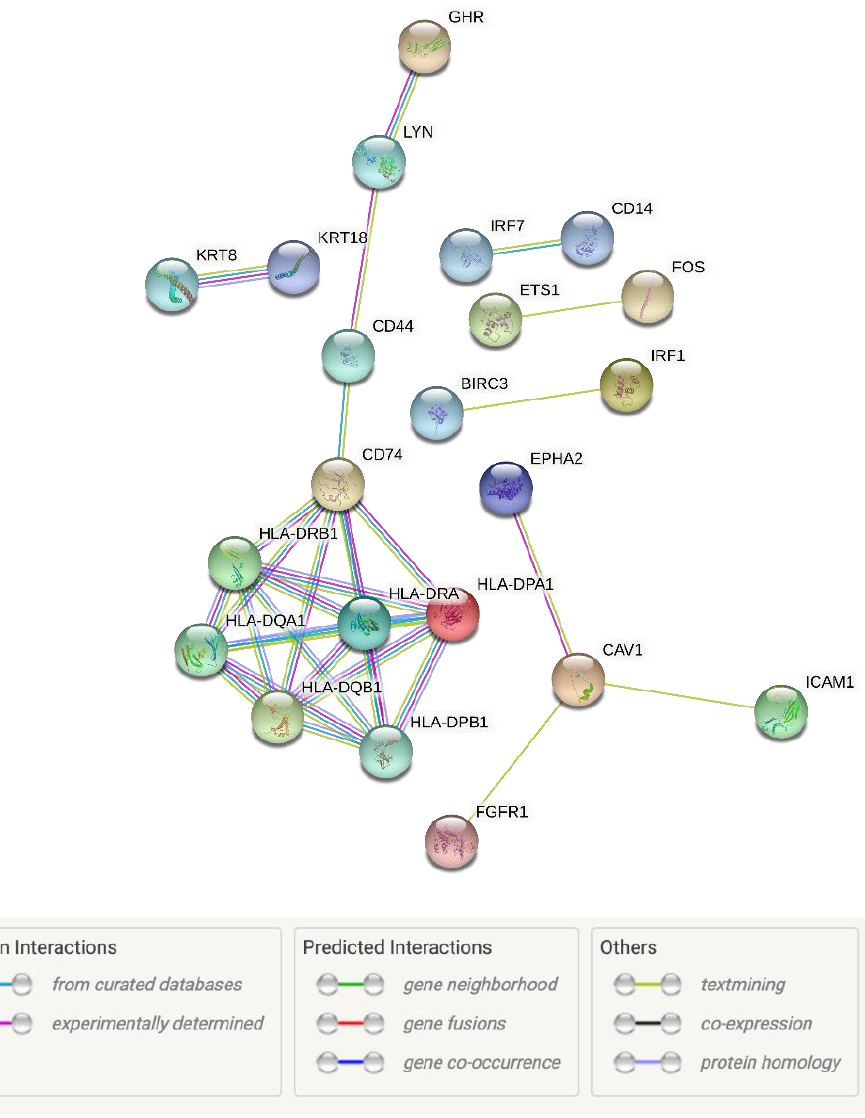
Figure 6. Interaction network of proteins encoded by the 22 most changed DEGs belonging to “defense response to other organism”, “defense response”, “defense response to virus”, “cytokine secretion”, “cytokine production” and “cytokine-mediated signaling pathway” GO BP terms. The network was generated using STRING software. The network nodes represent the structures of proteins encoded by the genes of interest. Empty nodes indicate proteins with an unknown 3D structure.